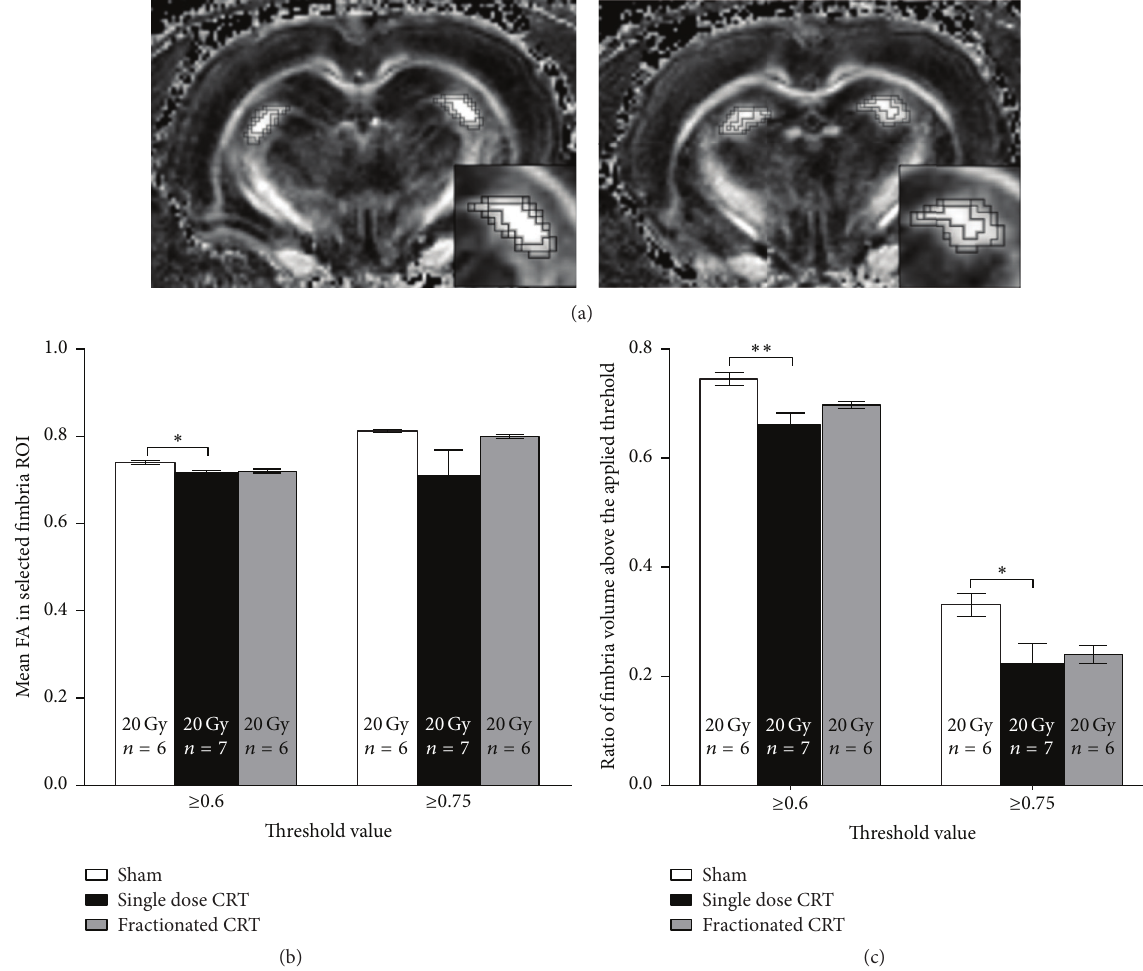
Figure 4: (a) Representational images of the fimbria in sequential cross sections. Concentric thresholded ROIs, representing thresholds of 0.5, 0.6, and 0.75 successively from large to small. Zoomed in insert has been added to better visualize the ROIs. (b) Mean FA values ( ± SEM) at 3mo after CRT in the ROI within the fimbria determined by the threshold value. Note that single dose CRT had a reduction in mean FA in voxels ≥ 0.6FA. (c) Ratio of fimbria volumes ( ± SEM) at 3 mo after CRT. There was a reduction in the ratio of the fimbria volume with the applied FA thresholds of ≥ 0.6 and 0.75 in the single dose CRT animals only [ ∗ 𝑝 < 0.05 , ∗∗ 𝑝 < 0.01